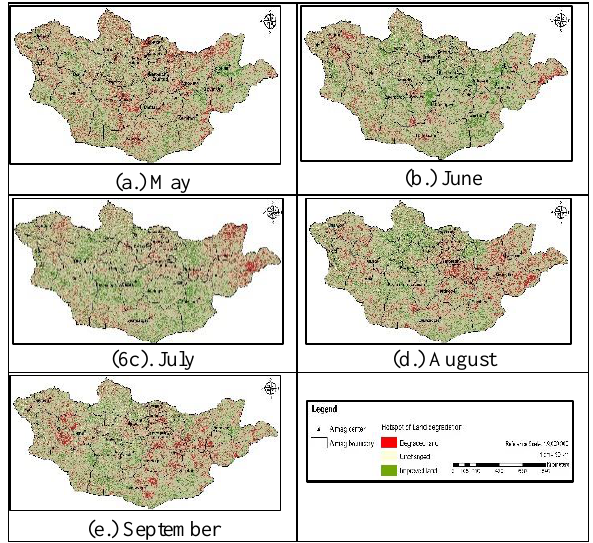
Figure 6. The hotspot of degraded land area of Mongolia